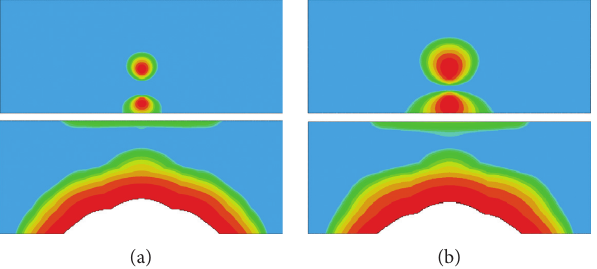
Figure 19: Distribution of the interfacial damage for the moment when the maximum vertical deformation is achieved for different E upper and bottom two panels are for the compression stage and the rebound stage, respectively. (a) E s � 1.0 MPa/mm. (b) E s � 2.0 MPa/mm.